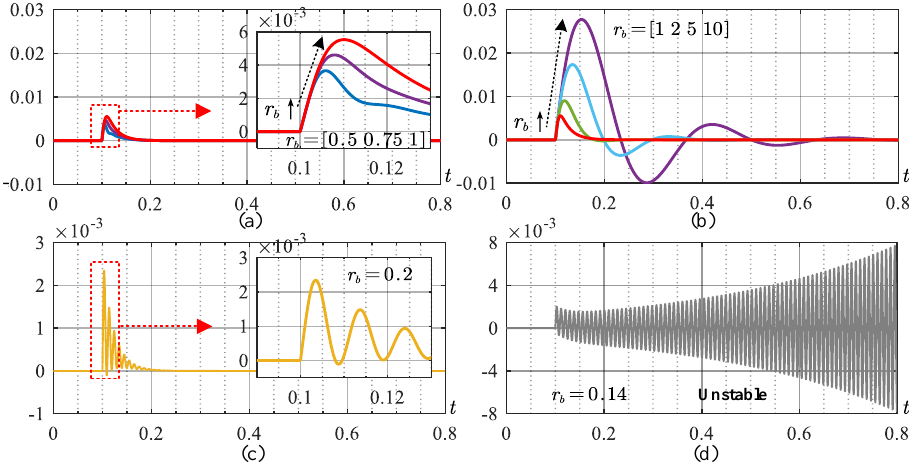
  G s under different f